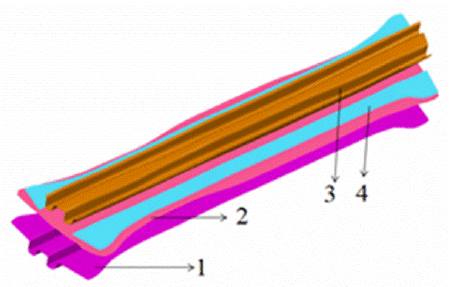
Figure 4. 3D model of hot stamping of the vehicle anti-collision beam; 1—female dye, 2—sheet, 3—punch, 4—blank holder. Table 3. Hot stamping process scheme.